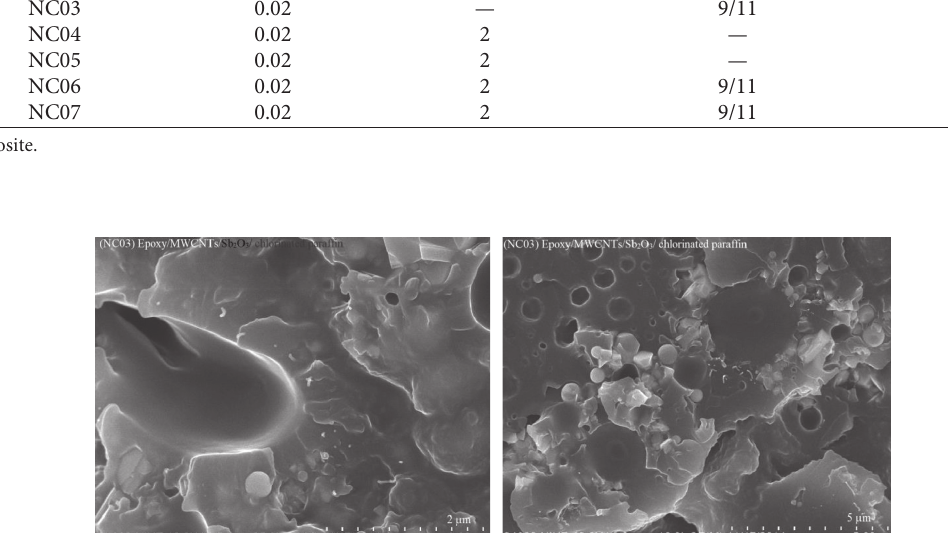
Figure 3: FE-SEM of the sample nanocomposites: epoxy Epikote 240/MWCNTs/epoxidised linseed Oil/Sb